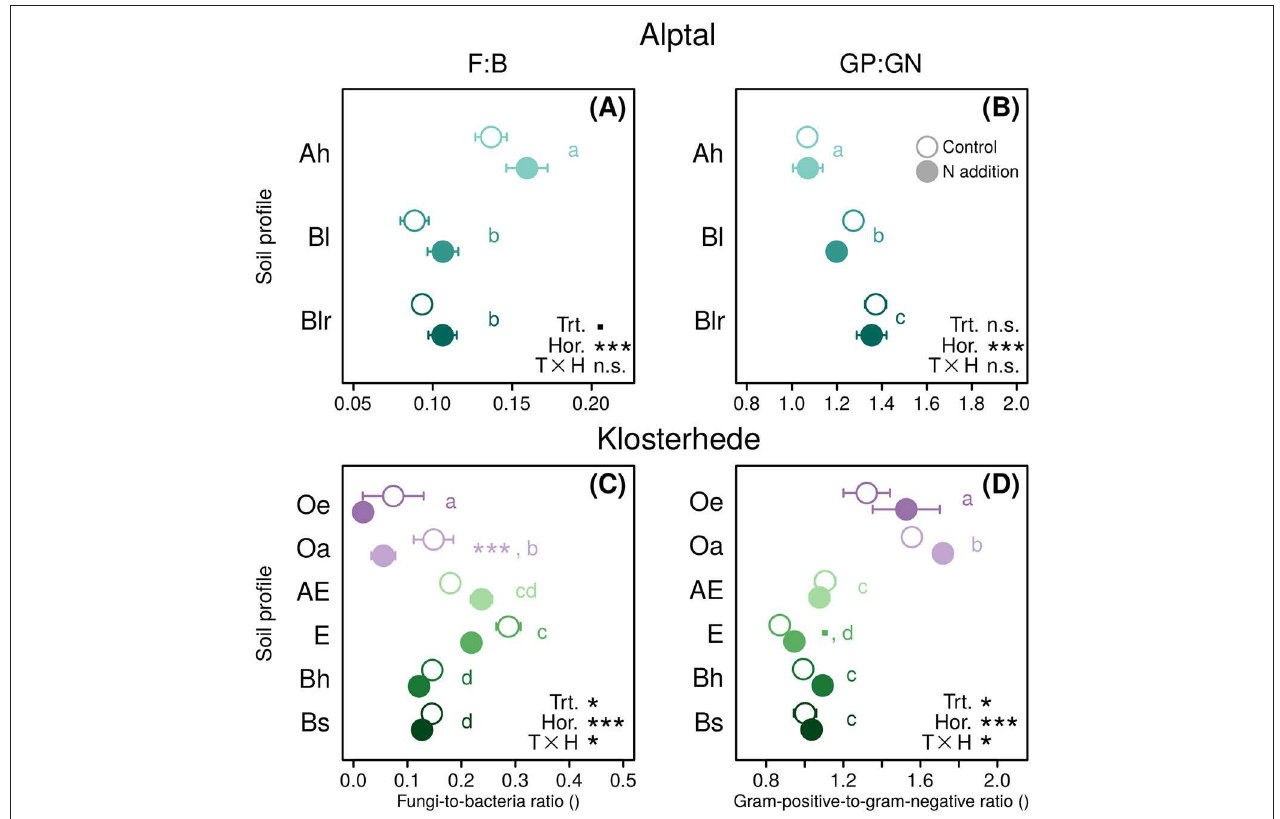
FIGURE 4 | Ratios of fungi-to-bacteria (F:B) and Gram-positive-to-Gram-negative bacteria (GP:GN) in response to N addition along the topsoil profile (0–30cm) at Alptal (A,B) and Klosterhede (C,D) . Post-hoc differences between control and N addition treatment within soil horizon are indicated by symbols next to circle pairs ( (cid:4) P < 0.1; * P < 0.05; ** P < 0.01; *** P < 0.001). Lower-case letters indicate post-hoc differences between soil horizons across treatments. Means with no letter in common are significantly different (Tukey’s HSD, α =